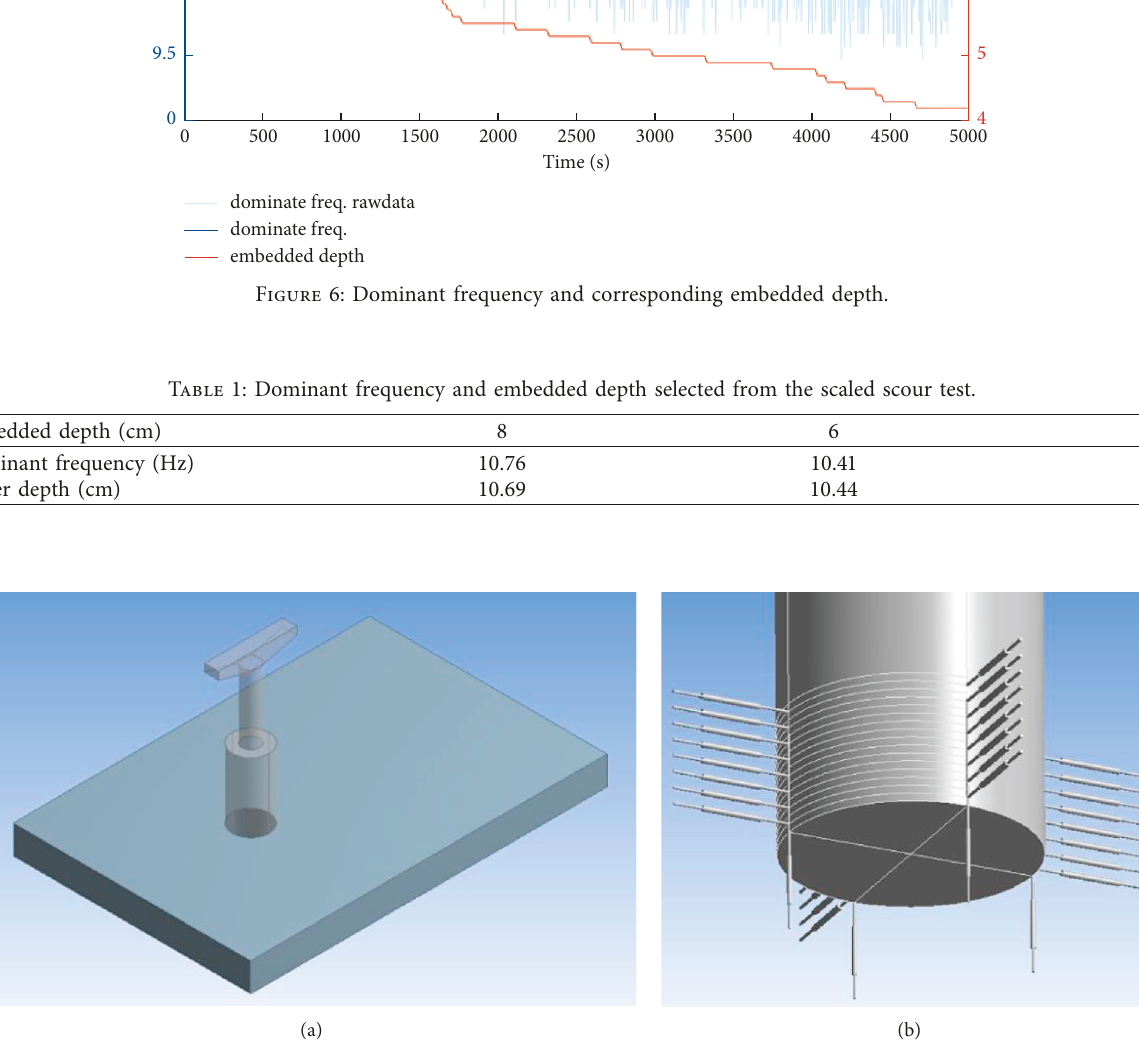
Figure 7: Numerical model in FSI simulation. (a) Bridge pier and fluid block. (b) Soil springs in the model.